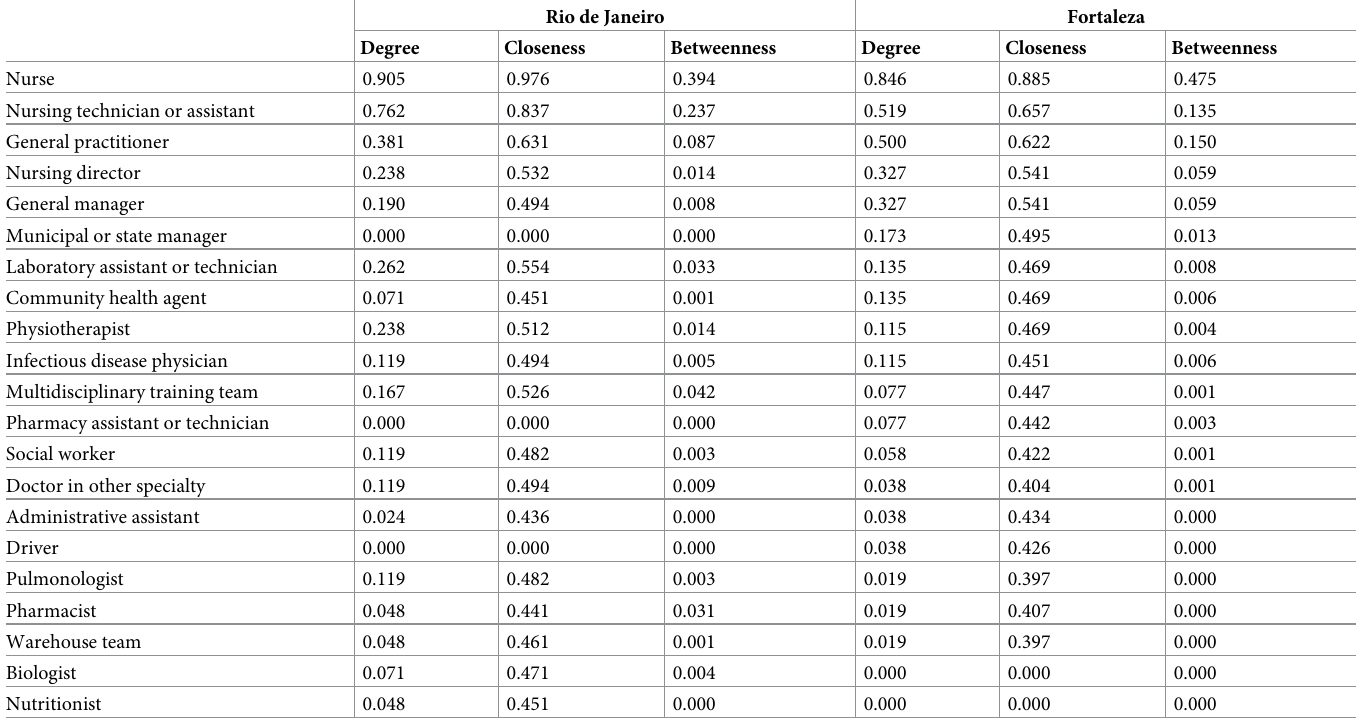
Table 1. Centrality measures of nurses’ social network–Rio de Janeiro and